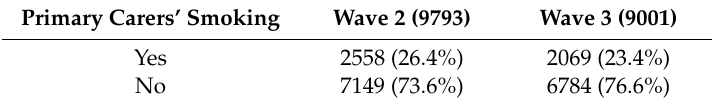
Table A1. Primary Carers’ smoking status at each wave (Wave 1 and wave 2).